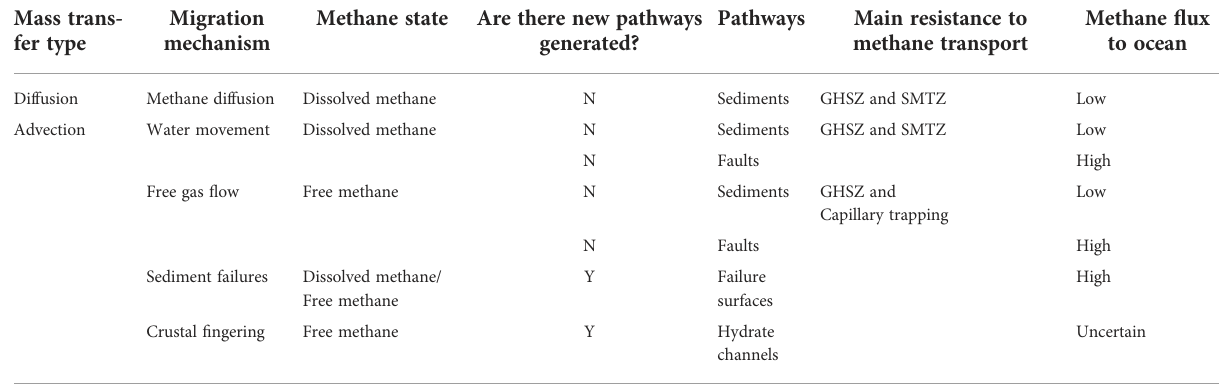
TABLE 5 Summary of mechanisms for methane